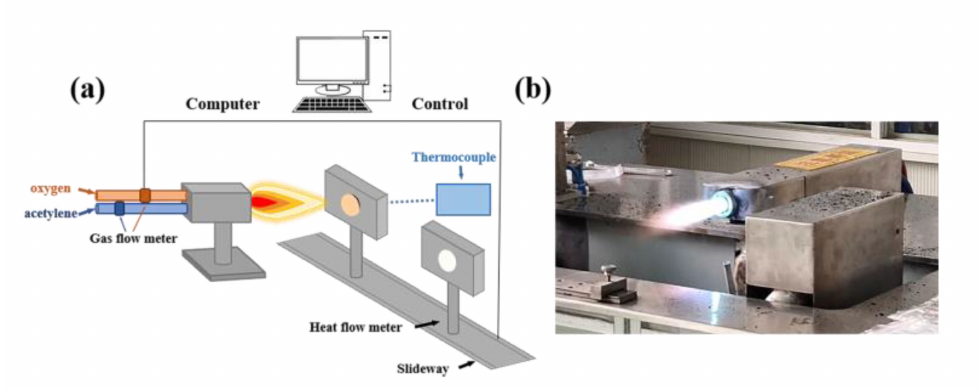
Figure 3. Schematic diagram ( a ) and realistic picture ( b ) of the oxyacetylene ablation